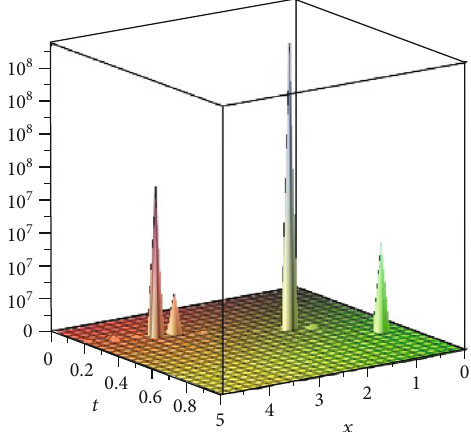
ð x , 0, 0, t Þ of Equation (69). Figure 17: u 2,3